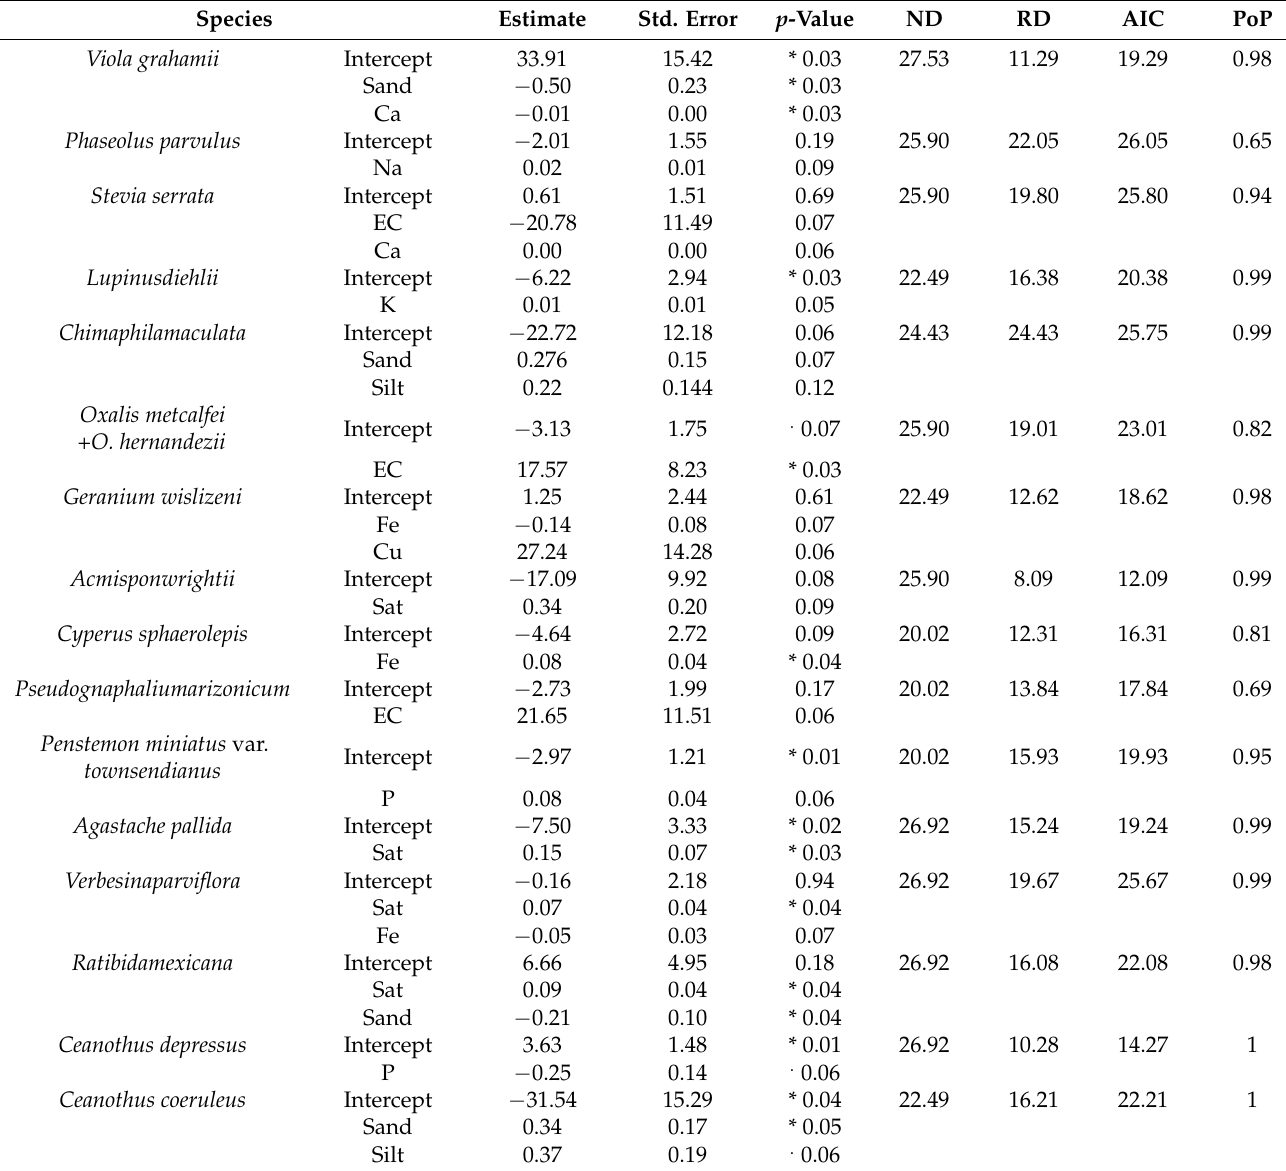
Table 4. Binomial logistic regression model coefficients for soil variables explaining the species presence under the canopy and in